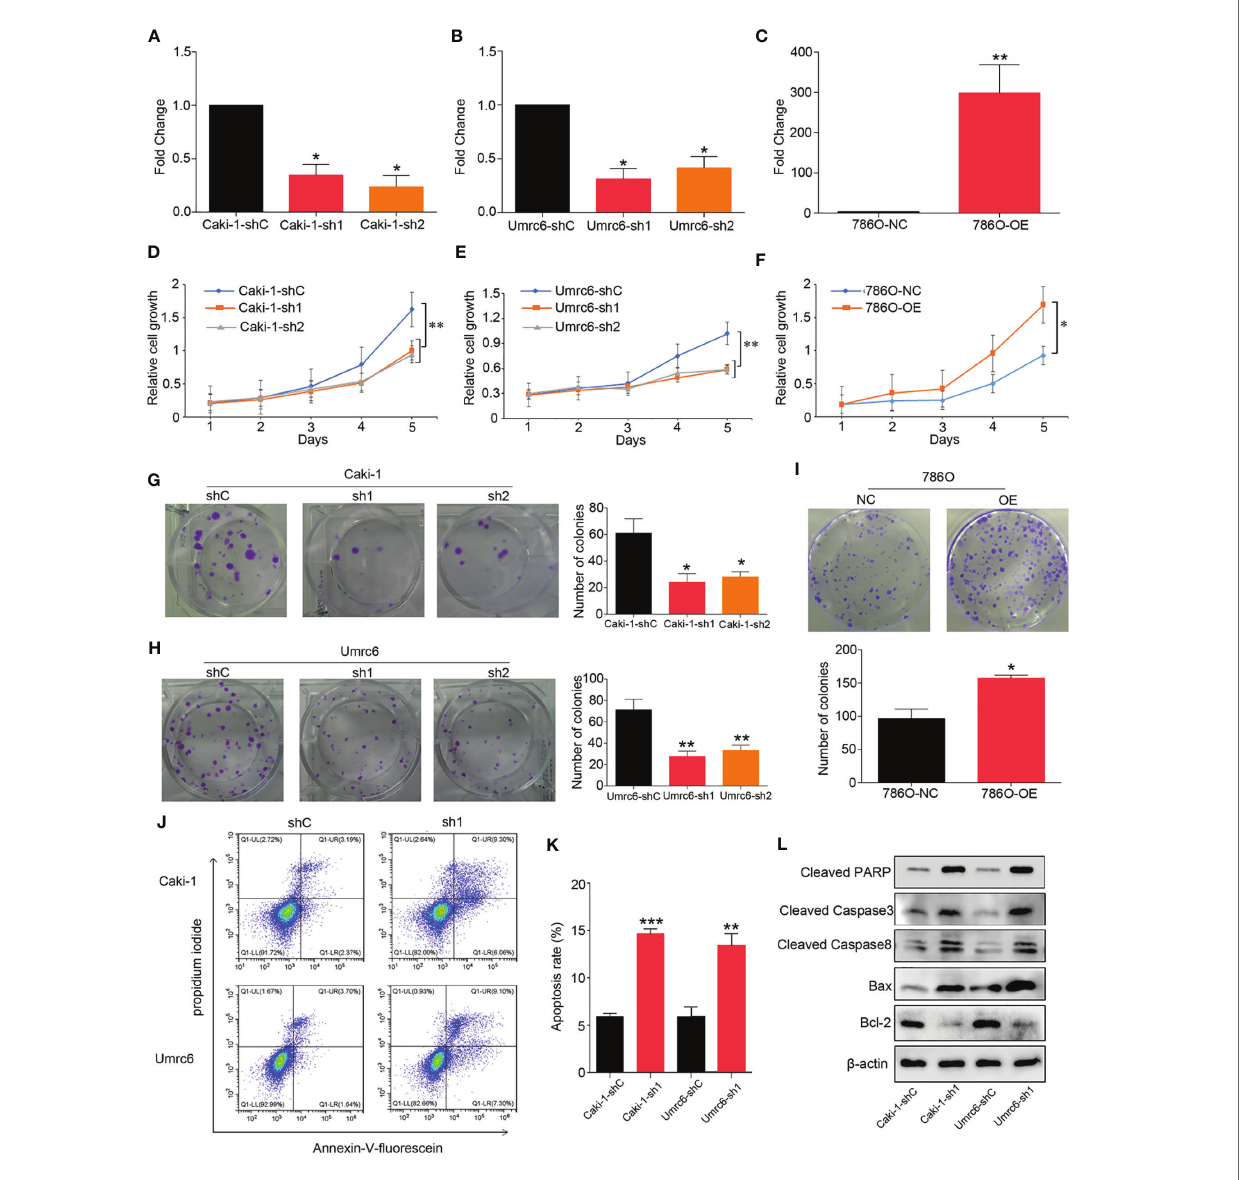
FIGURE 3 | DUXAP9 facilitated proliferation and inhibited apoptosis in renal cancer cells. (A, B) DUXAP9 was knocked down in renal cancer cells using shRNA1 or shRNA2 targeting DUXAP9. (C) DUXAP9 was overexpressed in the 786O cells (786-O). Proliferation of renal cancer cells after DUXAP9 knockdown or overexpression, as detected by (D – F) CCK-8 assays and (G – I) colony formation assays. (J, K) Apoptosis rate of DUXAP9-knockdown renal cancer cells, as detected by fl ow cytometry. (L) Apoptosis-related proteins in DUXAP9-knockdown renal cancer cells, as detected by western blotting. b -actin was used as the loading control. Data represent mean ± SD from three independent experiments. shRNA, short hairpin RNA; sh1, shRNA1; sh2, shRNA2; shC, shRNA negative control; OE, DUXAP9 overexpression; NC, overexpression negative control; CCK-8, cell counting kit-8; *P < 0.05; **P < 0.01; ***P <